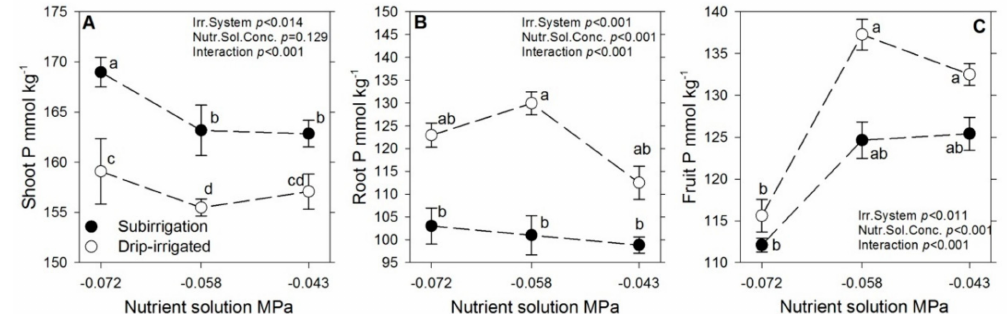
Figure 5. ( A – C ) E ff ect of the irrigation system and the concentration of the nutrient solution on phosphorus concentration in tomato ( Solanum lycopersicum L.) plants. ANOVA significance for both factors, irrigation system (Irr. System) and nutrient solution concentration (Nutr. Sol. Conc.), and the interaction is shown. Means with the same lower-case letter indicate non-significant di ff erences according to Tukey’s multiple comparison test. Bars represent the standard error of the mean ( n =